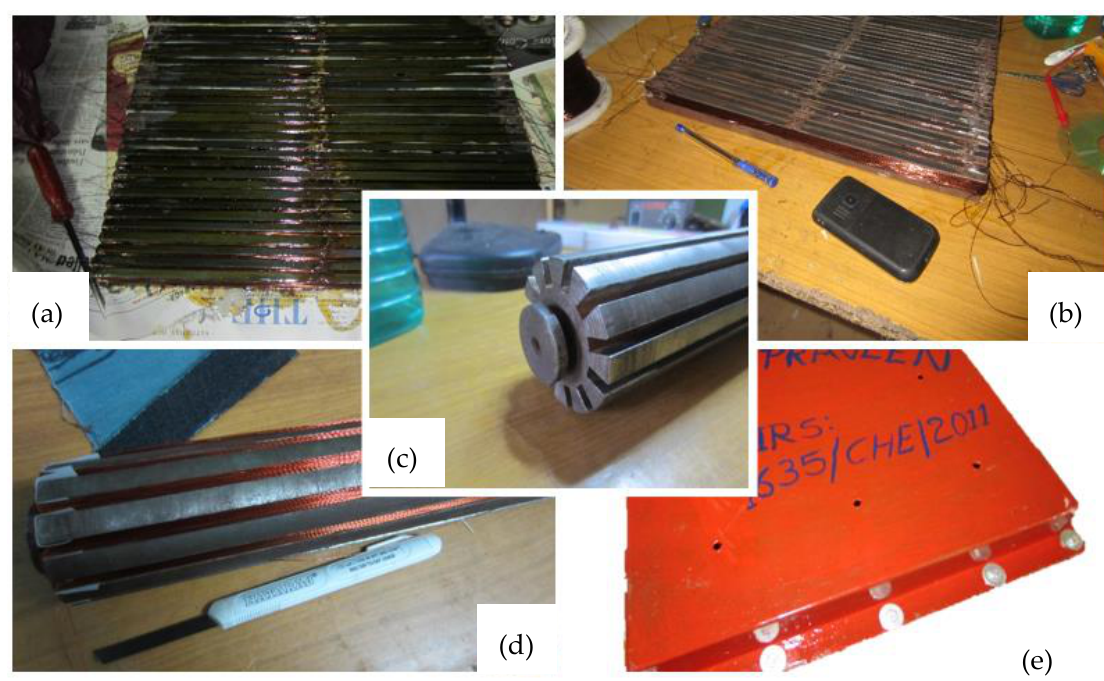
Figure 13. Prototype design: ( a , b ) top and bottom stator plate winding; ( c ) rotor without winding; ( d ) rotor with winding; ( e ) enclosed complete wave energy converter.